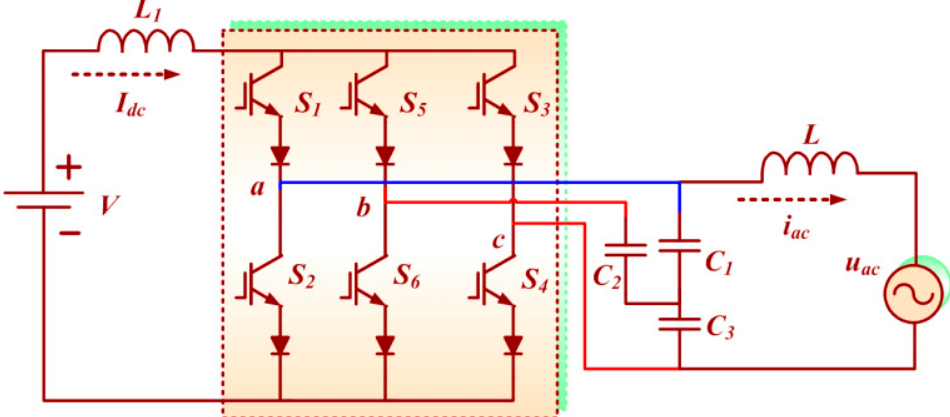
Figure 8. Power decoupling solution in [35].